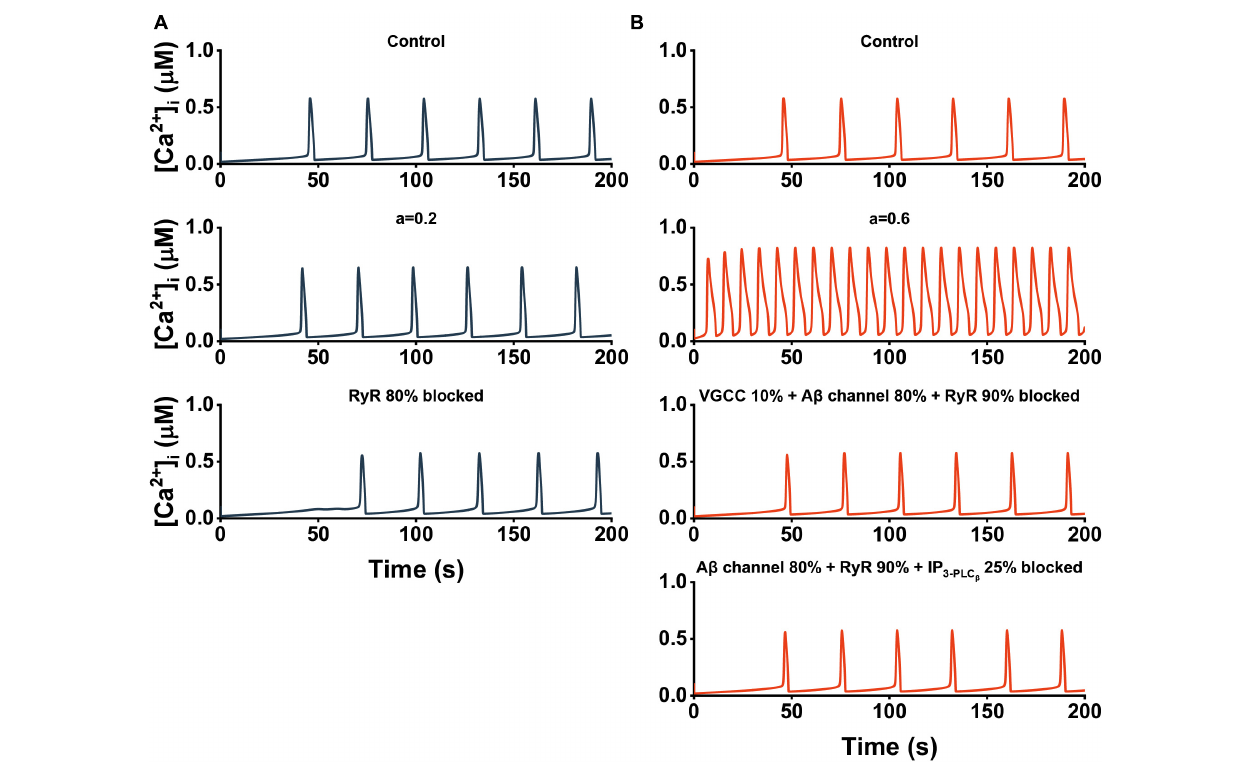
FIGURE 8 | The cytosolic Ca 2 + dynamics after treatment. (A) Effect of single therapy at the early stage of AD. Top, a = 0. Middle, a = 0.2. Bottom, a = 0.2 + single therapy. (B) Effect of “combination therapy” at the advanced stage of AD. Top, a = 0. Middle, a = 0.6. Bottom, a = 0.6 + two different “combination